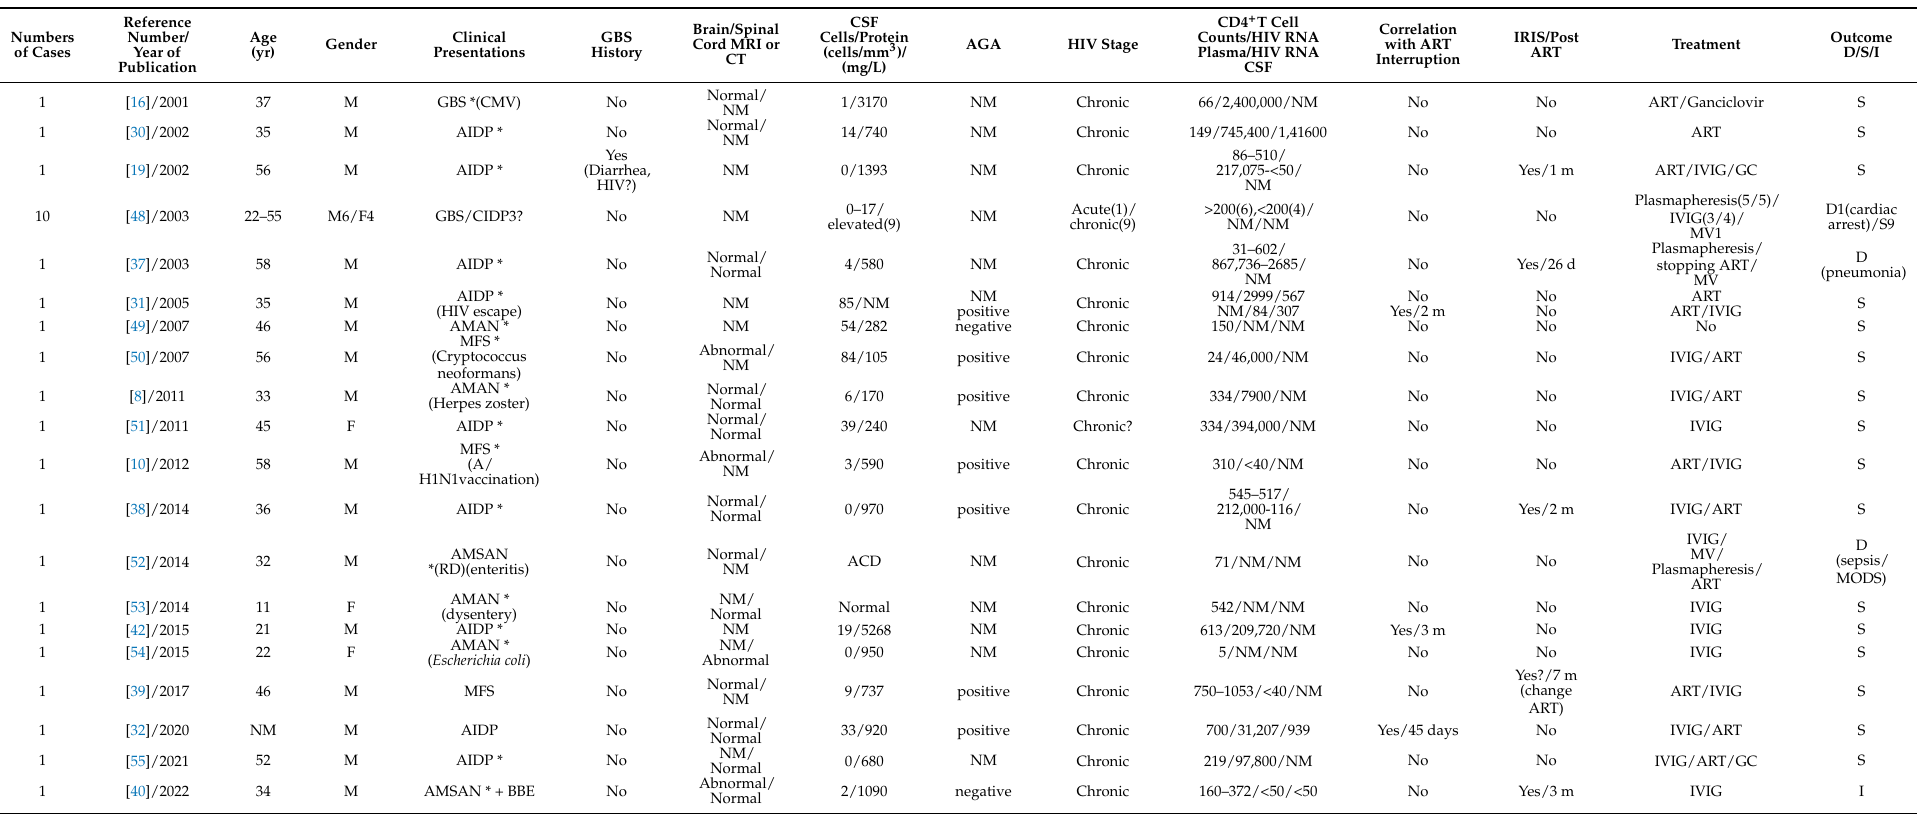
Table 2. The chronic HIV-infected cases with